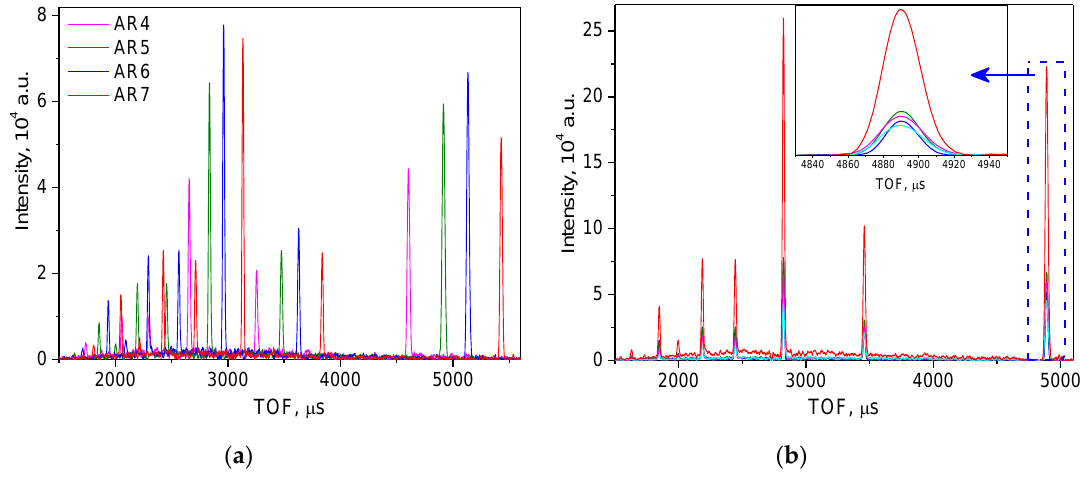
Figure 10. ( a ) Diffraction spectra from individual elements of the ASTRA detector; ( b ) Diffraction spectra from individual elements of the ASTRA detector, reduced to a unified TOF scale and the final total spectrum.